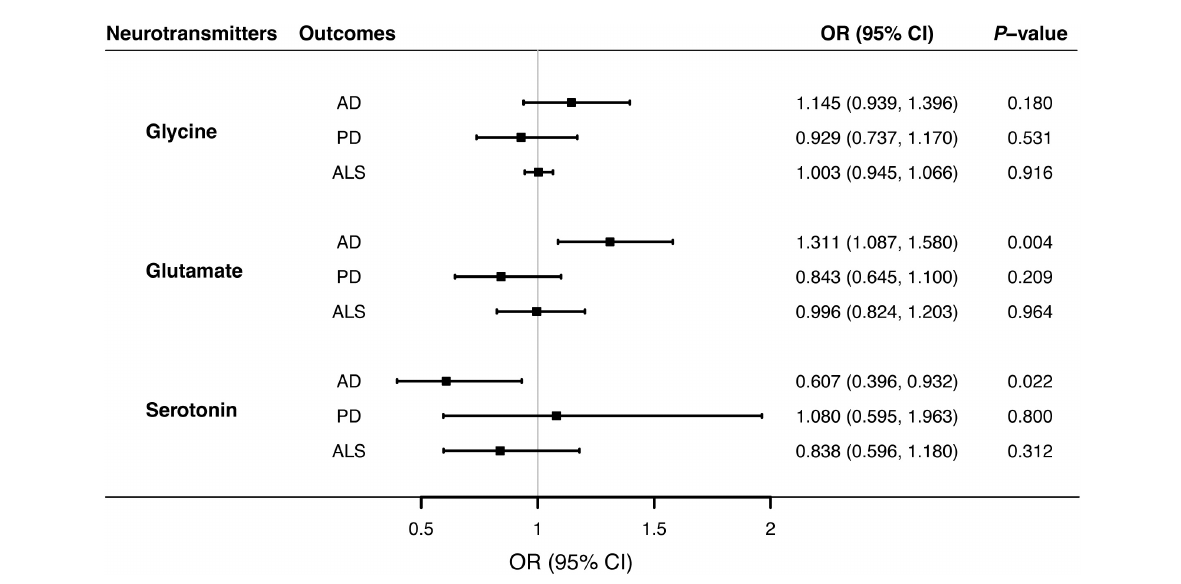
FIGURE1 Associations of genetically predicted blood neurotransmitter levels of with risks of neurodegenerative diseases via Mendelian randomization analyses. Causal effects of circulating glycine glutamate, and serotonin concentrations on the risks of AD, PD, and ALS were estimated by the inverse-variance weighted MR, and illustrated with forest plots. Solid blocks denoted effect sizes of point estimates, and horizontal lines represented 95% confidence intervals. Given the Bonferroni-corrected threshold at 0.05/9 (0.0055) to account for multiple testing, the study showed that elevated glutamate levels were associated with higher risks of AD ( P = 0.004). There was suggestive evidence supporting the protective effect of circulating serotonin on AD ( P = 0.022). AD, Alzheimer’s disease; ALS, amyotrophic lateral sclerosis; CI; confidence interval; MR, Mendelian randomization; OR, odds ratio; PD, Parkinson’s disease.